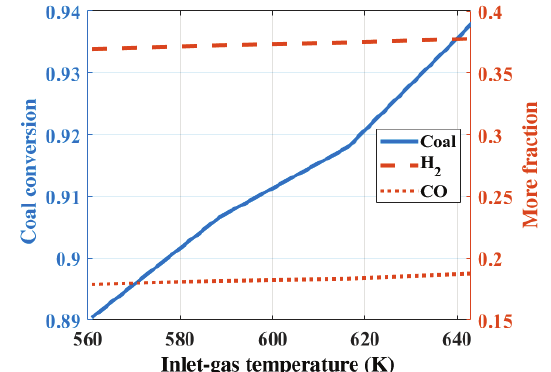
Fig. 5 – Effects of inlet-gas temperature on outlet solid con- version and syngas composition (reactor pressure = 23.8 atm)